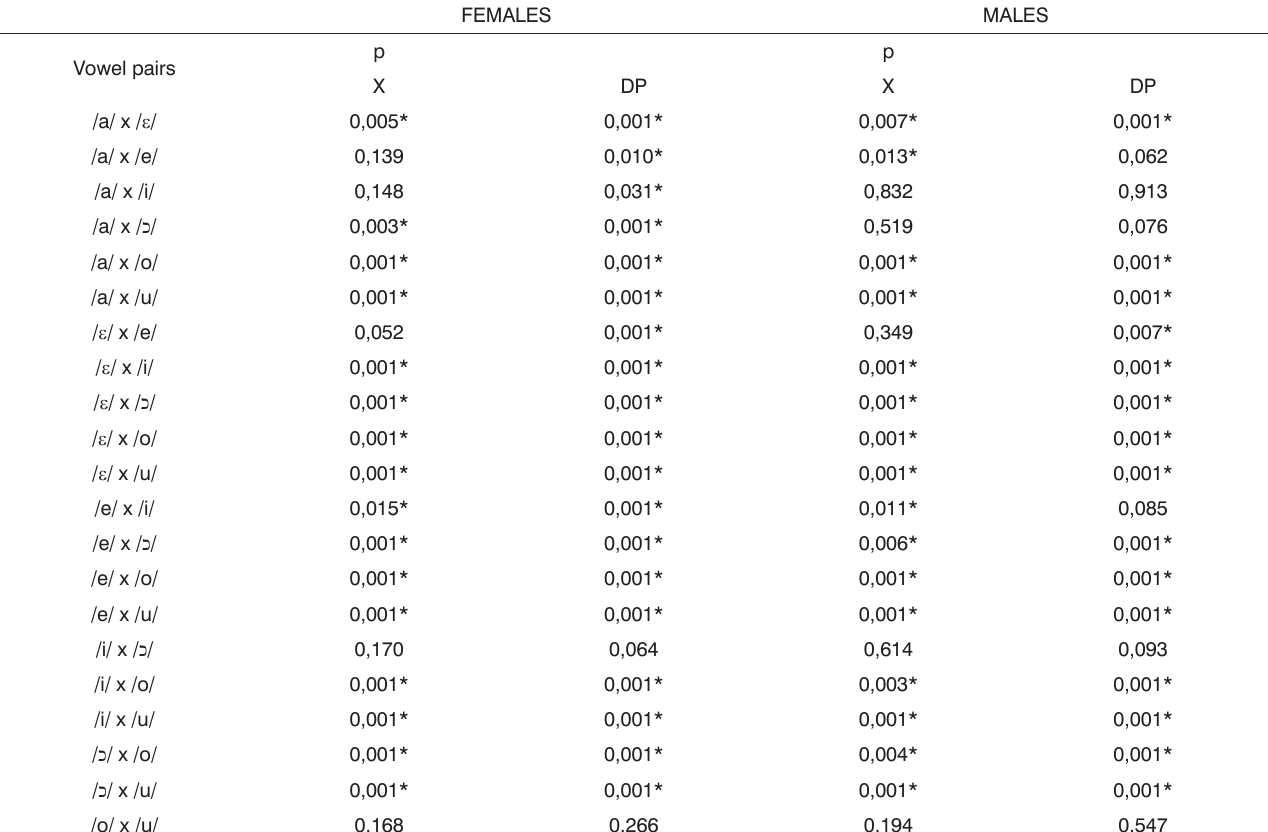
Table 2. p values in the paired analysis of vowel harmonic intensity mean values and respective standard deviations for each gender group. FEMALES MALES